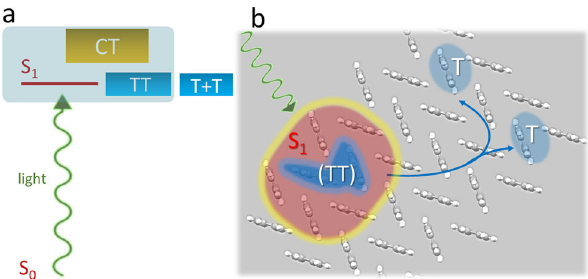
Fig. 1 Schematic of the singlet- fi ssion process. a Energy level arrangement of ground and excited singlet states (S 0 and S 1 ), triplet pair (TT), the independent triplets (T + T) and charge-transfer (CT) states. Teal shade indicates the possibility of state mixing. b Example of spatial arrangement and interconversion of species involved in ultrafast singlet fi ssion, including initial delocalization of S 1